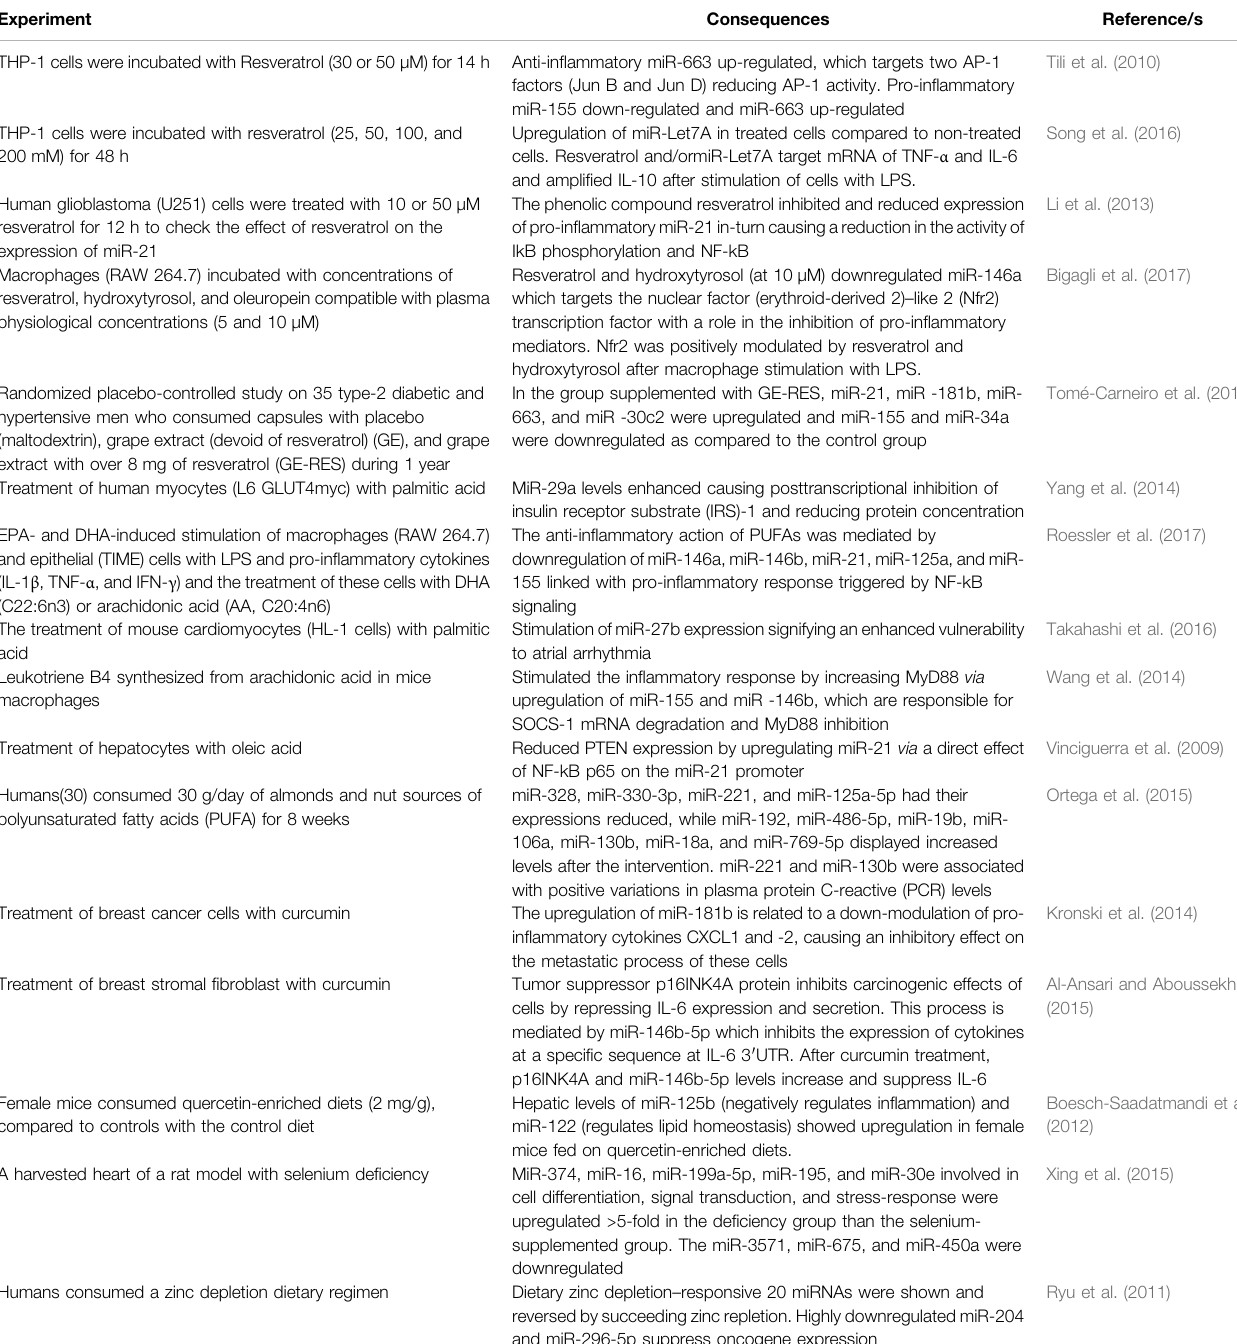
TABLE 2 | Studies of miRNAs modulated by respective nutrient and bioactive